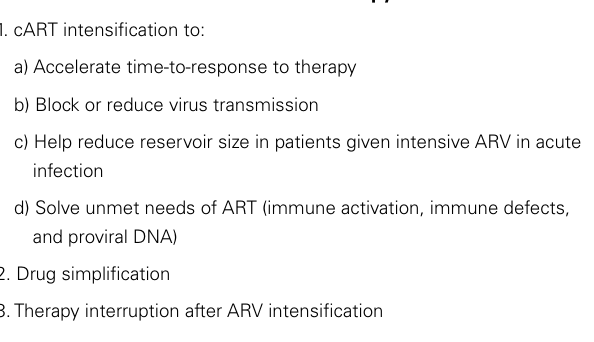
Table 1 | Rationale for therapeutic immunization of HIV-infected individuals